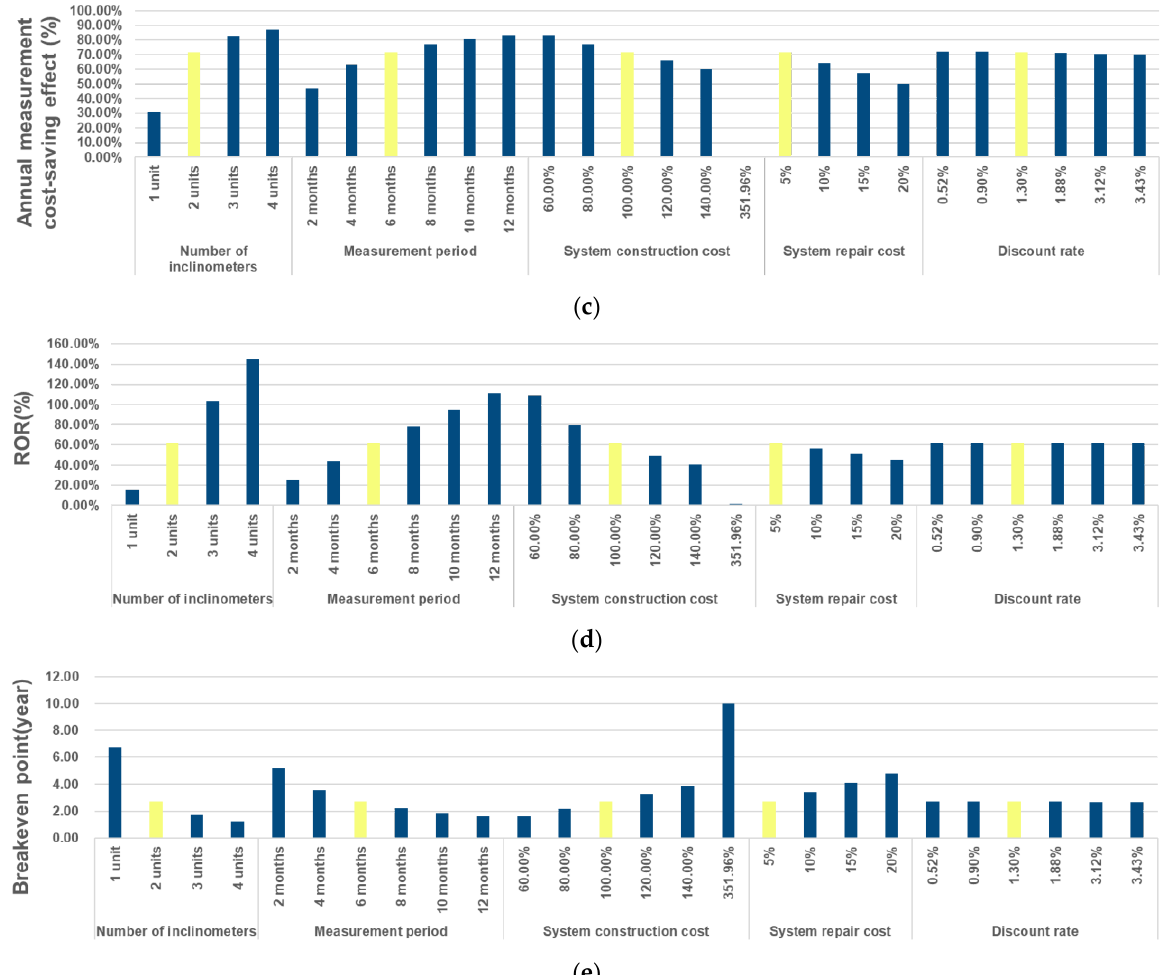
Figure 17. Sensitivity analysis results regarding the LCC analysis variables and assumptions. ( a ) Present worth analysis; ( b ) benefit/cost (B/C) ratio analysis; ( c ) annual measurement cost-saving effect analysis; ( d ) ROR analysis; ( e ) breakeven point analysis .